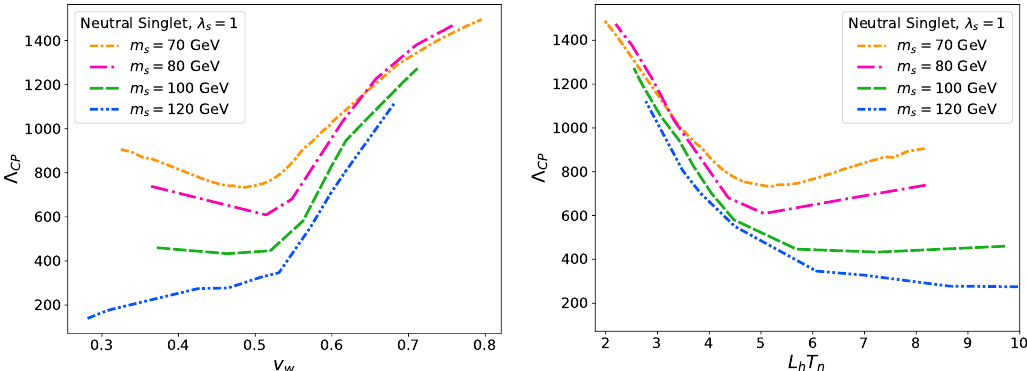
Figure 9 . Prediction for the BAU normalized to its observed value in the scalar singlet model using the correct variables in front of the wall T v w (orange dash-dot). The parameters have been fixed as indicated. The horizontal axis gives the wall velocity of each parameter set.